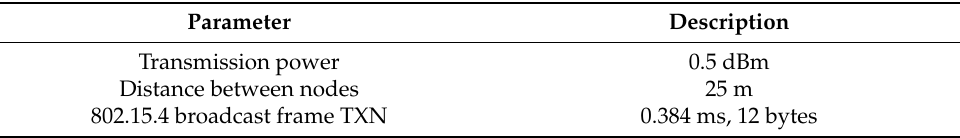
Table 5. Design parameters.